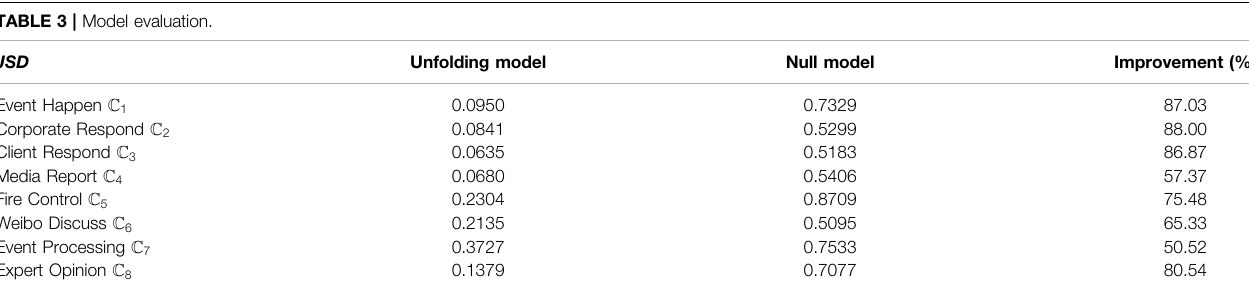
TABLE 3 | Model evaluation.